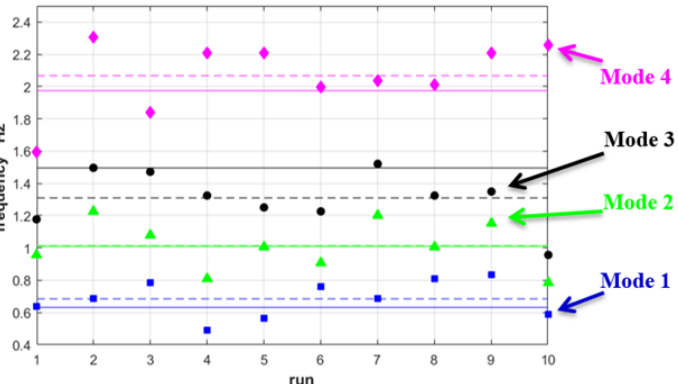
Figure 11. Values for the first four modal frequencies obtained by MM-PSD with 10 runs (colored dots) and average values (dashed lines) compared to OMA values (continuous lines).